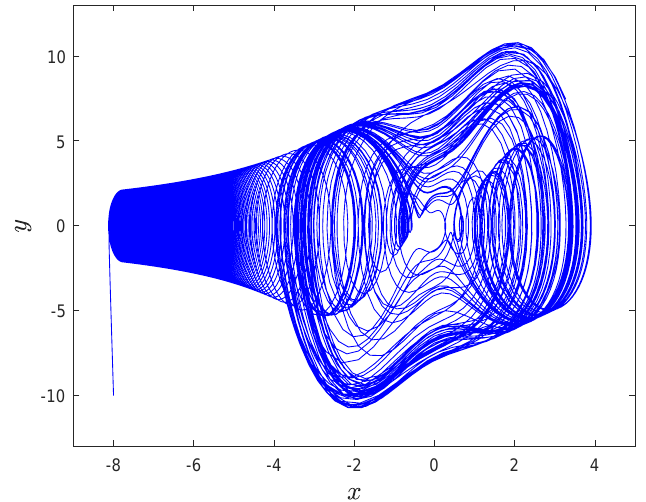
Figure 3. The attractor of dynamic system (6) with initial values ( x 0 , y 0 ) = ( − 8, − 10 )